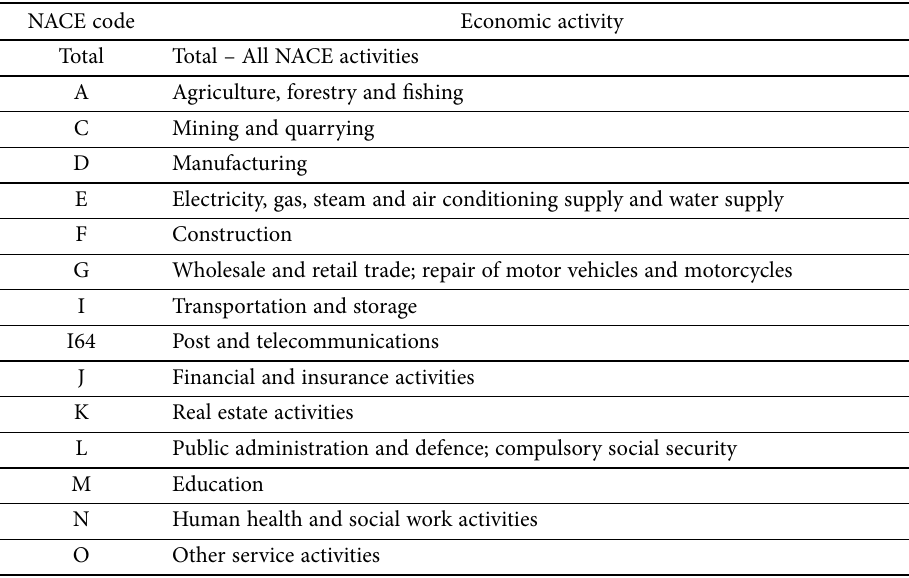
Table A1. Aggregates of statistical classification of economic activities (NACE rev. 1.1) applied to calculate CO2 emission and value added in Lithuania and EU-27 member states NACE